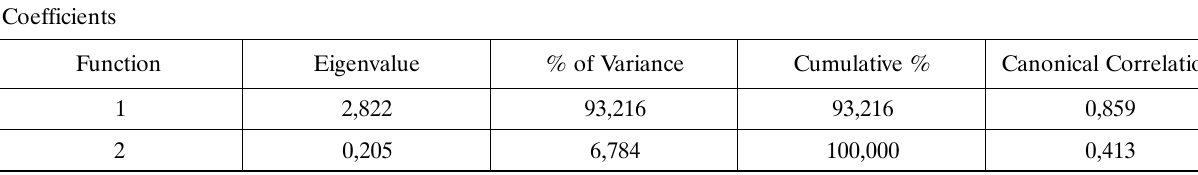
Table 3. Discriminant Analysis Functions and Wilks’ Lambda